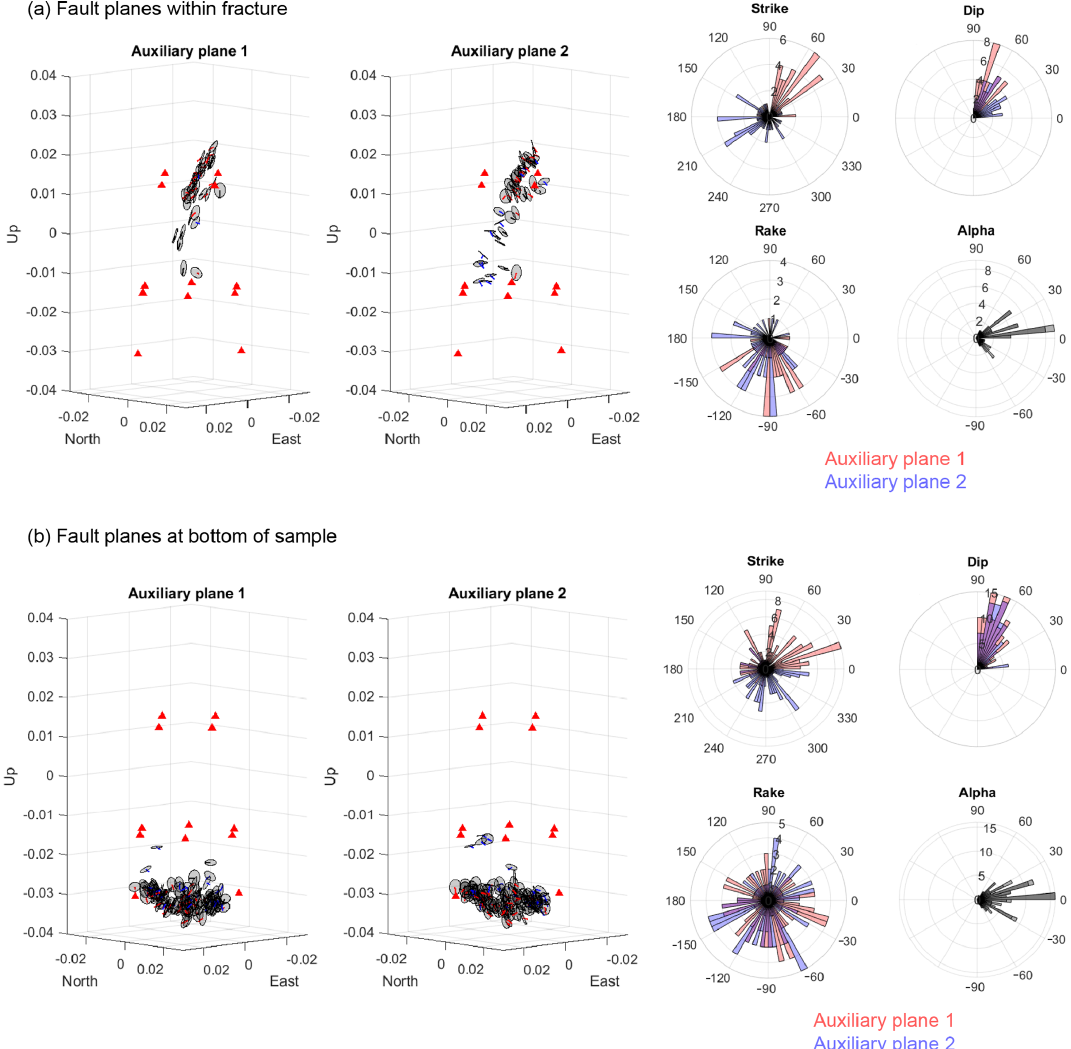
Figure 7. Results of the biaxial decomposition (Chapman and Leaney, 2012) applied to the subset of 418 moment tensors. (a) Fault planes of AE events contained within the fracture, rose plots of their strike, dip, rake and alpha angle. (b) The same results for AE events near the bottom of the